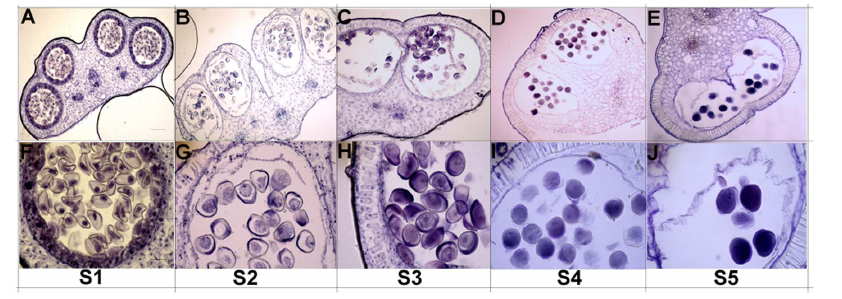
Figure 2. Transverse paraffin section images of anther. Image A and F show the anther in S1 stage; Image B and G show the anther in S2 stage; Image C and H show the anther in S3 stage; Image D and I show the anther in S4 stage; Image E and J show the anther in S5 stage. Bar in image A is 50 m m, and the images B, C, D, and E have the same magnification as image A. Bar in image F is 10 m m, and the images G, H, I, and J have the same magnification as image